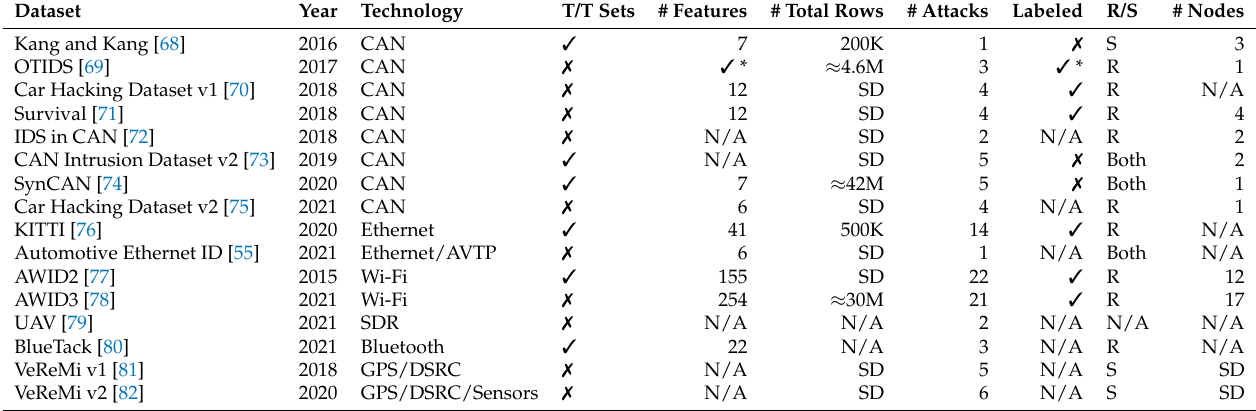
Table 3. Publicly available VIDS datasets sorted by technology and year in ascending order. The “*” denotes that the mentioned statement is partially applied. T/T: training/testing, R/S: realistic or simulated testbed, N/A: not applicable or unknown, SD: depends on the simulation